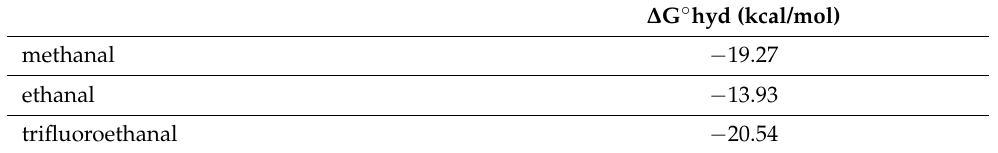
Table 5. ∆ G ◦ hyd (oxo-compound + H 2 O → hydrate) was calculated using acetone as a solvent. methanal − 19.27